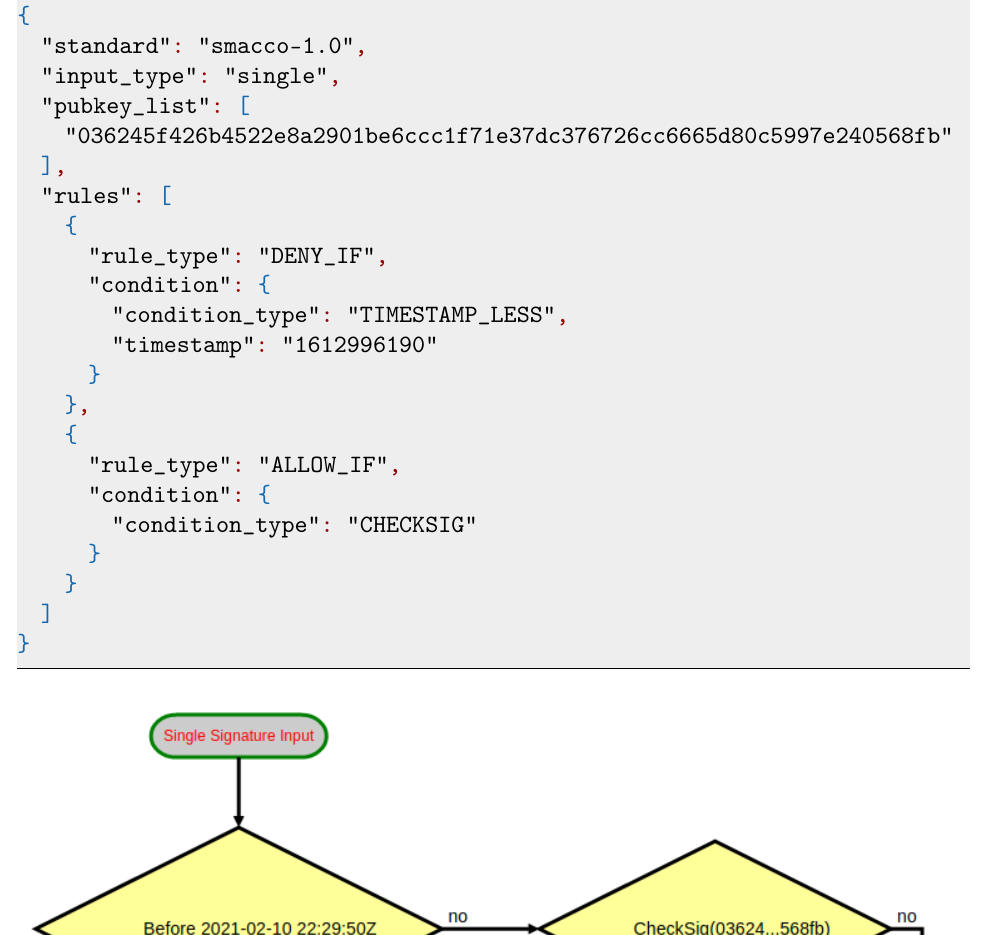
Algorithm 2 Code in JSON format for a time locked single account.